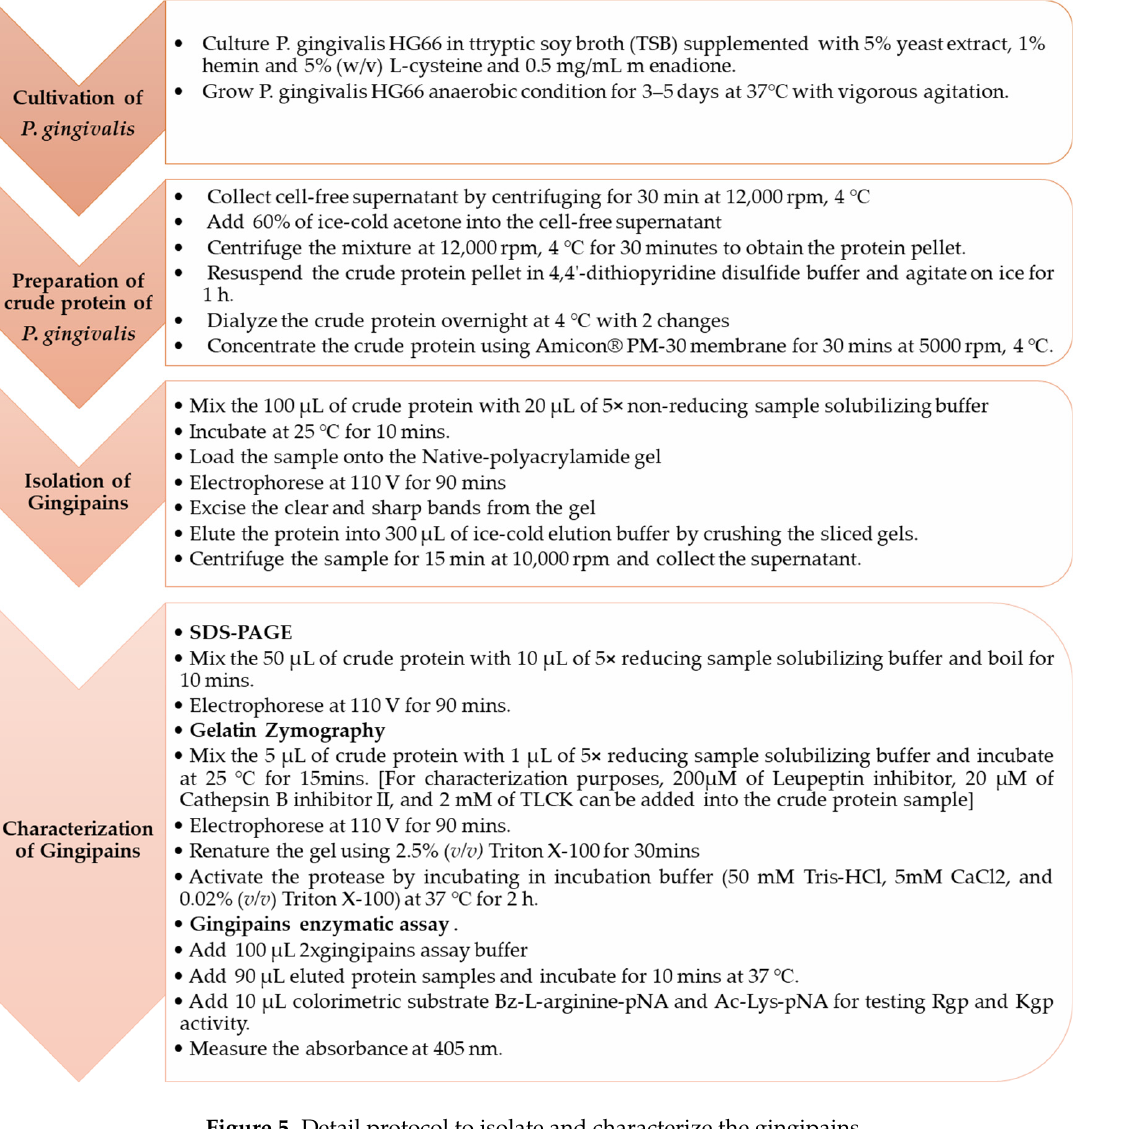
Figure 5. Detail protocol to isolate and characterize the gingipains.